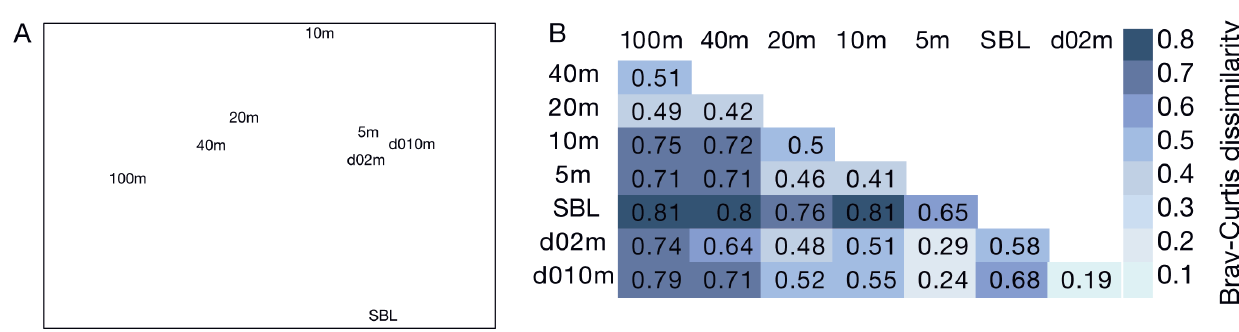
Fig. 7. (A) Non-metric multidimensional scaling (NMDS) ordinations based on the ranks of the Bray-Curtis dissimilarities between 16S DGGE fingerprints from the depth profile including the surface boundary layer (SBL) in the Comau Fjord and samples from 10 and 2 m depth at Huinay pier taken on Day 0 of the microcosm experiment. The figure shows axis 1 and 2 of a 3 dimensional ordination (stress = 0.006, R 2 = 1). (B) Bray-Curtis dissimilarity matrix for the DGGE